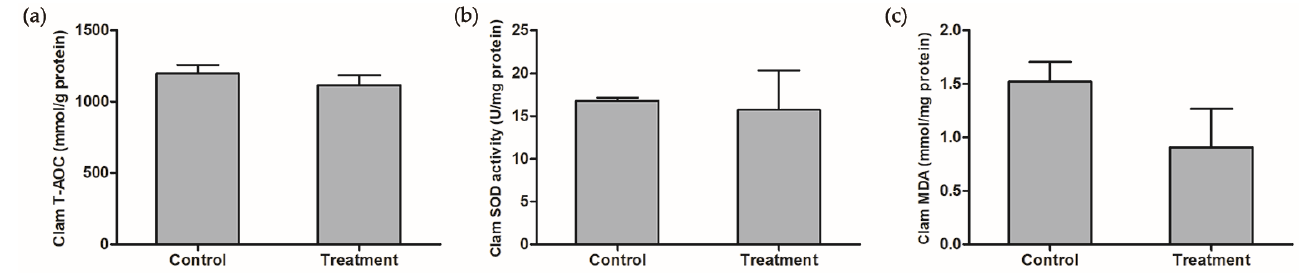
Figure 2. Antioxidant response of the clam Meretrix meretrix after exposure to Heterosigma akashiwo for 48 h. ( a ) Total antioxidant capacity (T-AOC); ( b ) superoxidase dismutase (SOD) activity; ( c ) malondialdehyde (MDA) content. Error bars represent standard deviations (n = 3).